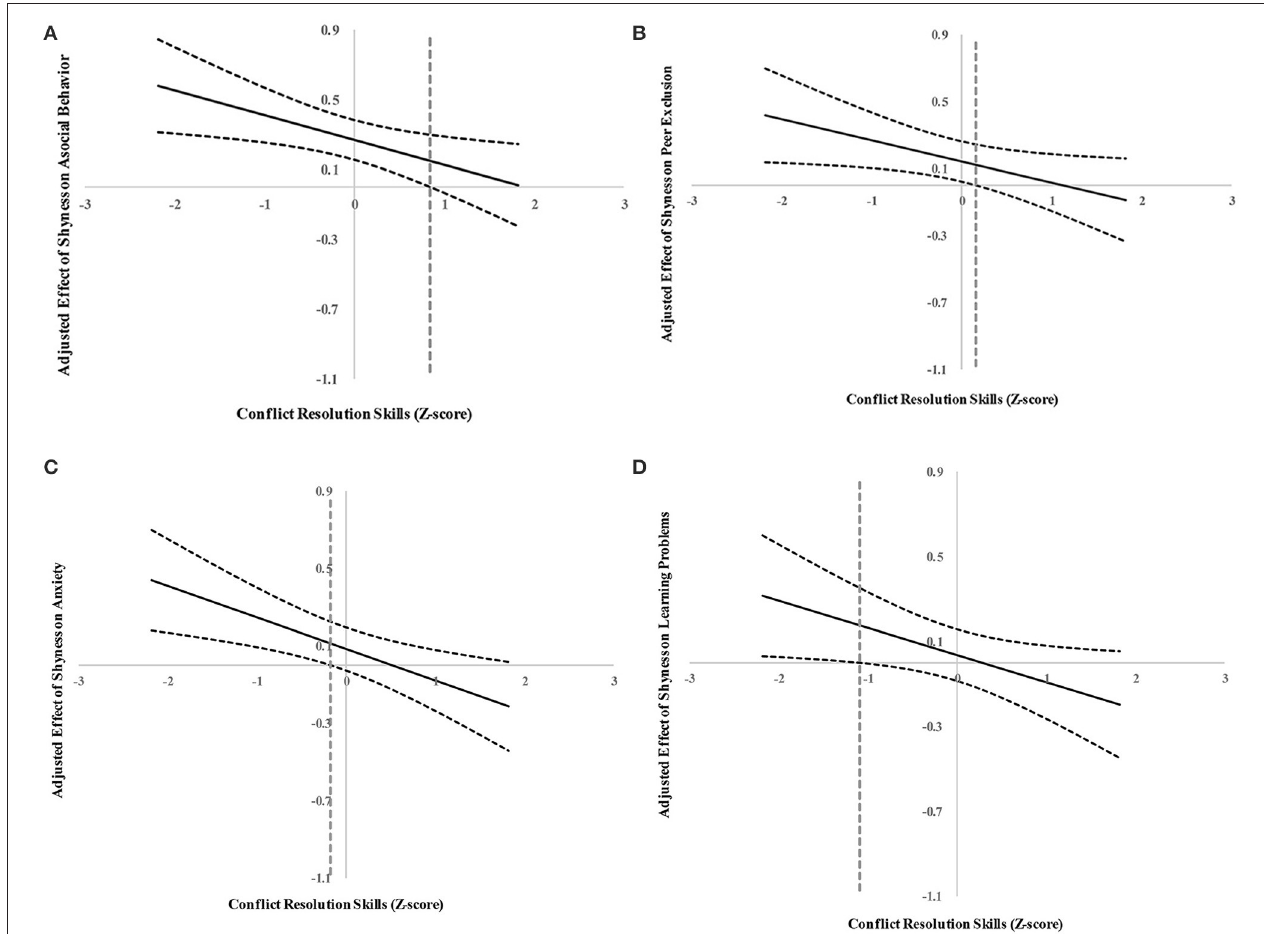
FIGURE 2 | (A) Adjusted effect of shyness on asocial behavior using the Johnson–Neyman technique. The dashed vertical line indicates the point along the conflict resolution skills in which shyness regression coefficient transitions from significance (left of the dashed vertical line) to non-statistical significance (right of the dashed vertical line). The value of the dashed vertical line was 0.84. (B) Adjusted effect of shyness on peer exclusion using the Johnson–Neyman technique. The dashed vertical line indicates the point along the conflict resolution skills in which shyness regression coefficient transitions from significance (left of the dashed vertical line) to non-statistical significance (right of the dashed vertical line). The value of the dashed vertical line was 0.16. (C) Adjusted effect of shyness on anxiety using the Johnson–Neyman technique. The dashed vertical line indicates the point along the conflict resolution skills in which shyness regression coefficient transitions from significance (left of the dashed vertical line) to non-statistical significance (right of the dashed vertical line). The value of the dashed vertical line was − 0.18. (D) Adjusted effect of shyness on learning problems using the Johnson–Neyman technique. The dashed vertical line indicates the point along the conflict resolution skills in which shyness regression coefficient transitions from significance (left of the dashed vertical line) to non-statistical significance (right of the dashed vertical line). The value of the dashed vertical line was −